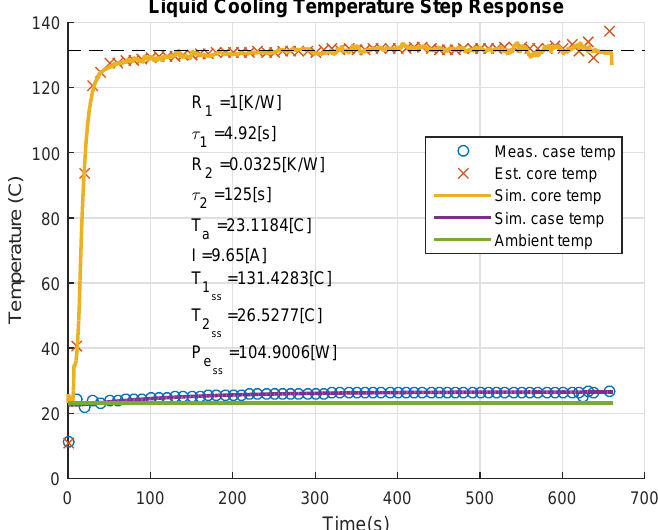
Figure 11. Thermal step response of the Maxon EC22 100-W motor with liquid